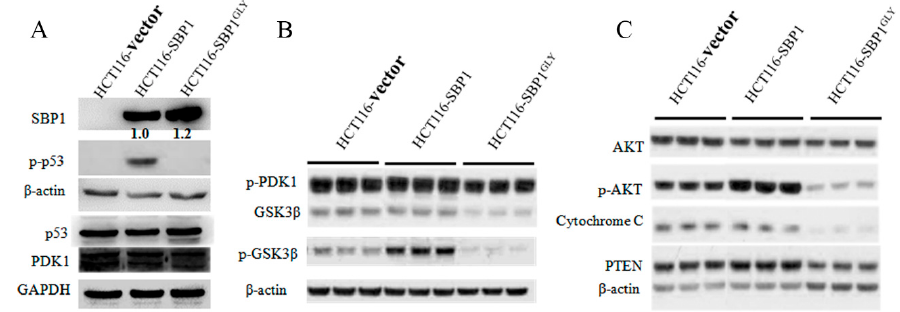
Figure 4. Differential effects of wild-type SBP1 and SBP1 GLY on signaling pathways relevant to carcinogenesis. ( A – C ) After 48 h of transfection of HCT116 cells with vector, pIRES2-SBP1, or pIRES2-SBP1C57G, protein levels including phospho-p53, p53, phospho-PDK1, PDK1, GSK3 β , phospho-GSK3 β , total AKT, phospho-AKT (serine 473), PTEN, and cytochrome C were examined by immunoblot analysis. SBP1 signals were quantified and normalized to β -actin. Relative intensities were indicated.